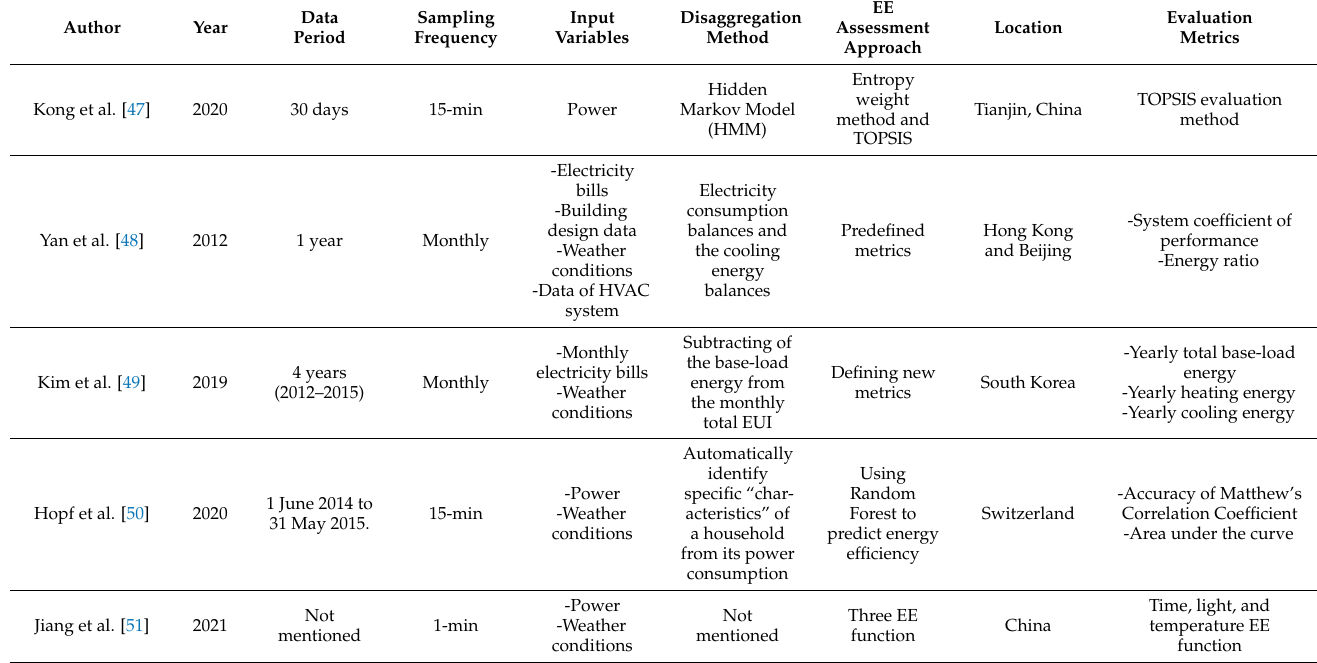
Table 3. NILM-based methods for energy efficiency assessment of